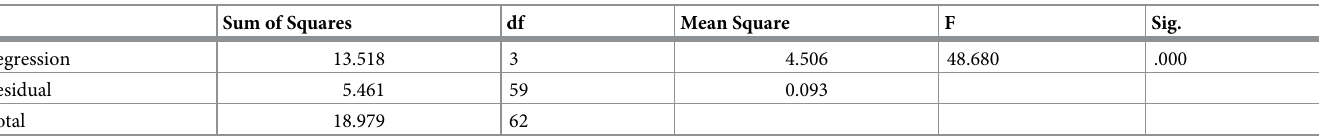
Table 18. ANOVA table.